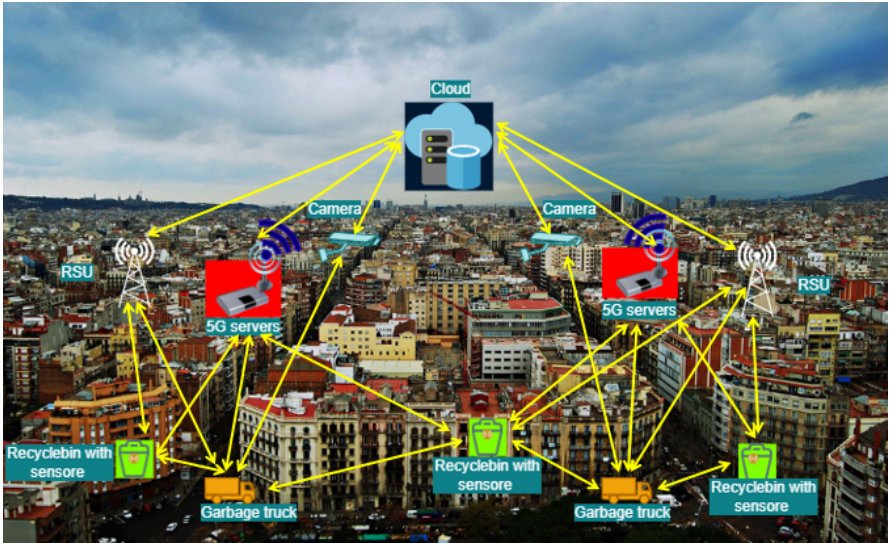
Figure 1. IoT for waste collection management in a smart